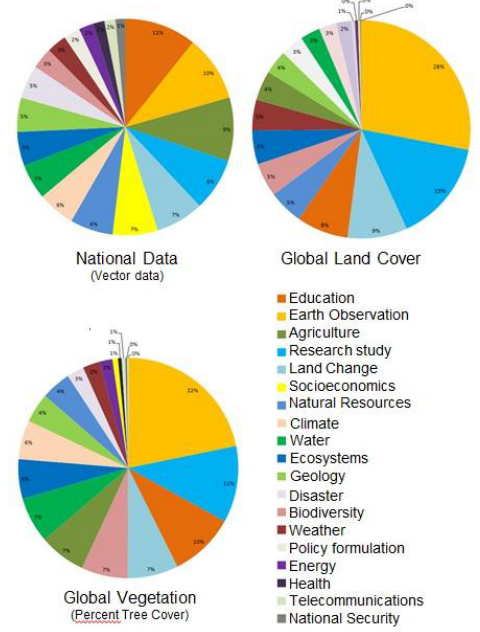
Figure 13: Purpose of data